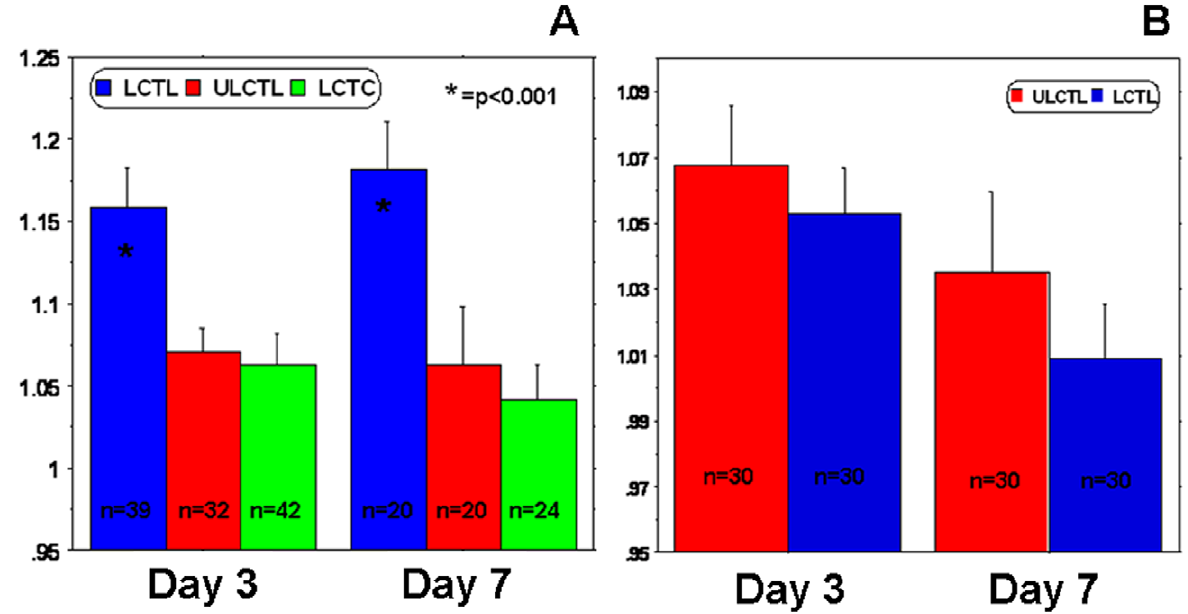
Figure 7. Relaxation parameters in tumors and radiation injuries. (A) Analyses of R2* values normalized to contralateral normal hemisphere (indirect indicator of the accumulation of iron positive cells) showed significantly higher (P= , 0.001) accumulation of iron positive cells in tumor that received labeled CTLs. The number of accumulated cells was higher at both, days 3 and 7. n represents the number of sections containing tumors in at least 5 animals. (B) Similar analyses of R2* values normalized to contralateral normal hemisphere showed no difference between the groups of animals that received labeled and unlabeled CTLs. n represents the number of sections included in the analyses from 6 animals (5 sections from each animal, at the level of bregma, 2 sections front and 2 sections